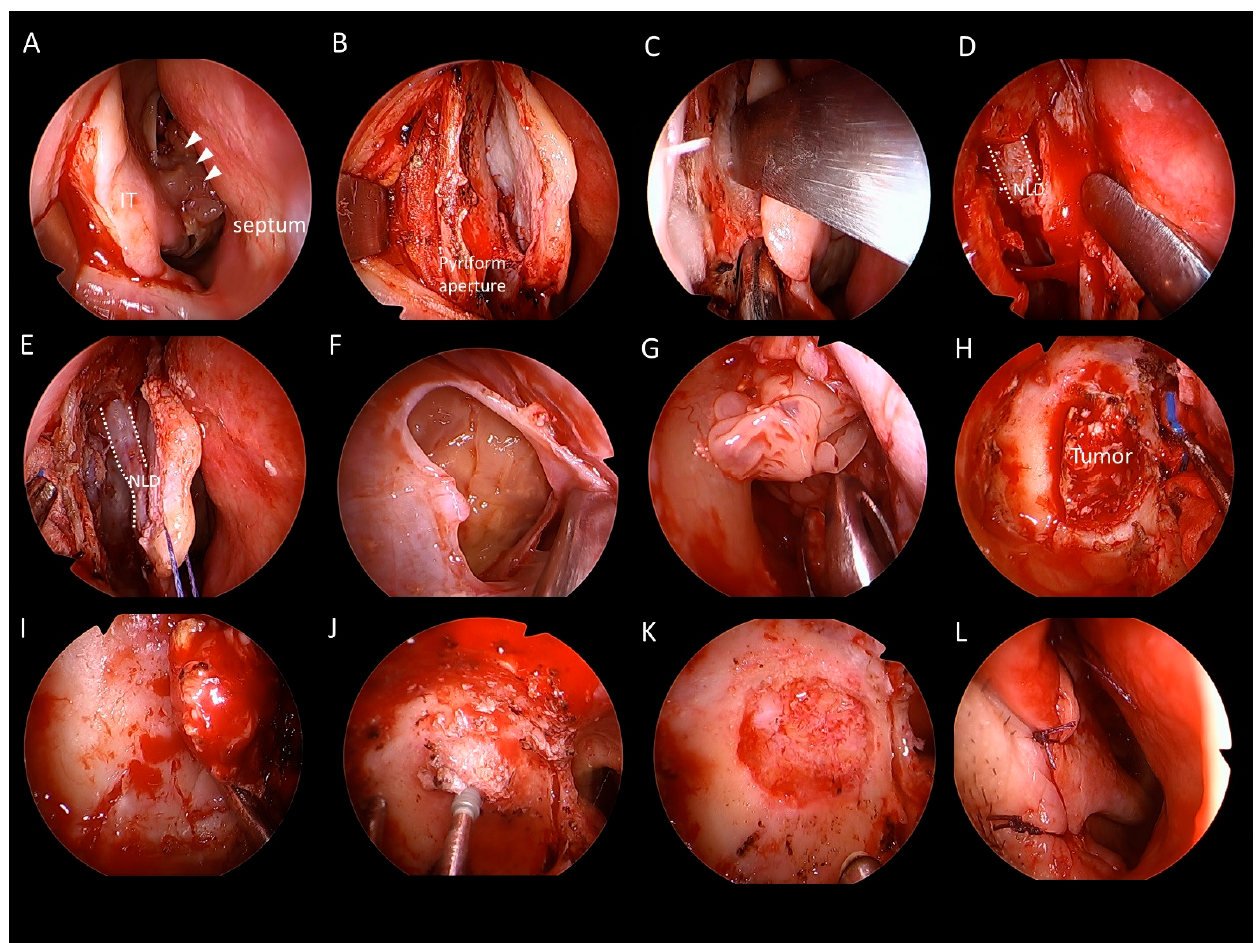
Figure 2. Prelacrimal recess approach in a patient with an inverted papilloma in the right maxillary sinus. ( A ) Curved incision from the lateral wall of the nasal cavity to the nasal floor. The arrows indicate inverted papilloma. ( B ) Bony pyriform aperture, lateral wall, anterior end of the IT, inferior meatus, and nasal floor are identified. ( C ) Prelacrimal bone osteotomy. ( D ) The NLD is easily identified while medializing the bony lateral wall of the nasal cavity. ( E ) The lateral wall flap consisting of the NLD and IT is tented medially, exposing the medial wall of the MS. ( F ) The bony medial wall of the MS is removed, and the mucosa incised. ( G , H ) The tumor in the MS is debulked, isolating the attachment site. ( I ) Multilayer centripetal resection with 1 cm margins. ( J ) Drilling the hyperostotic attachment site. ( K ) Wide MMA. ( L ) Repositioning the lateral wall flap.